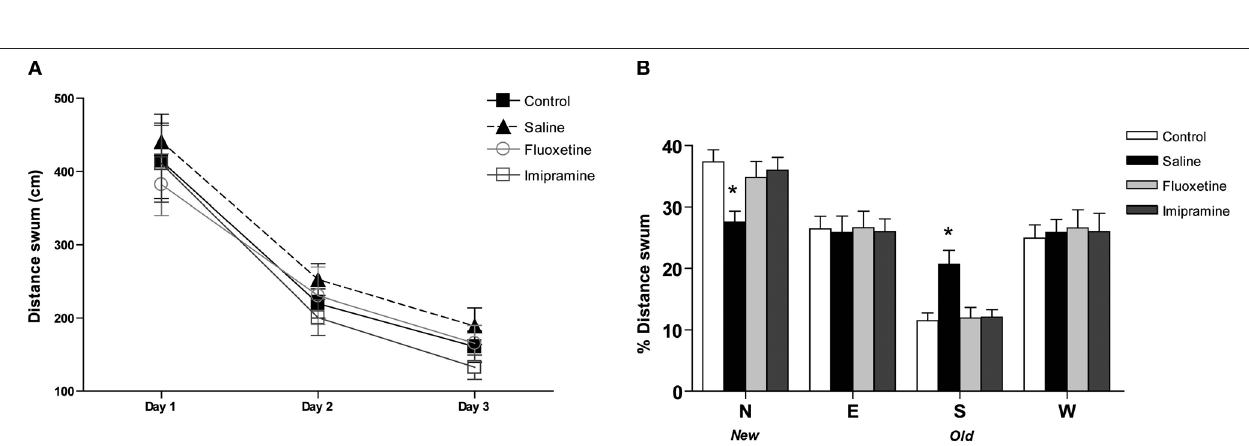
FIGURE 2 | Behavioral effects of antidepressants in the cognitive performance in the Morris watermaze. (A) Average distance swum in the spatial learning task and (B) the percentage of distance swum in each quadrant in the reverse learning task in the Morris watermaze. * P < 0.005. Data presented as mean ±